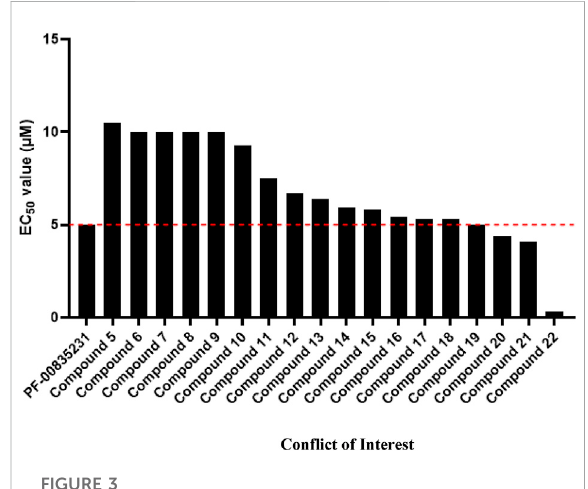
FIGURE 3 The EC 50 value of PF-00835231 and its derivatives to suppress SARS CoV-1 229E in MRC-5